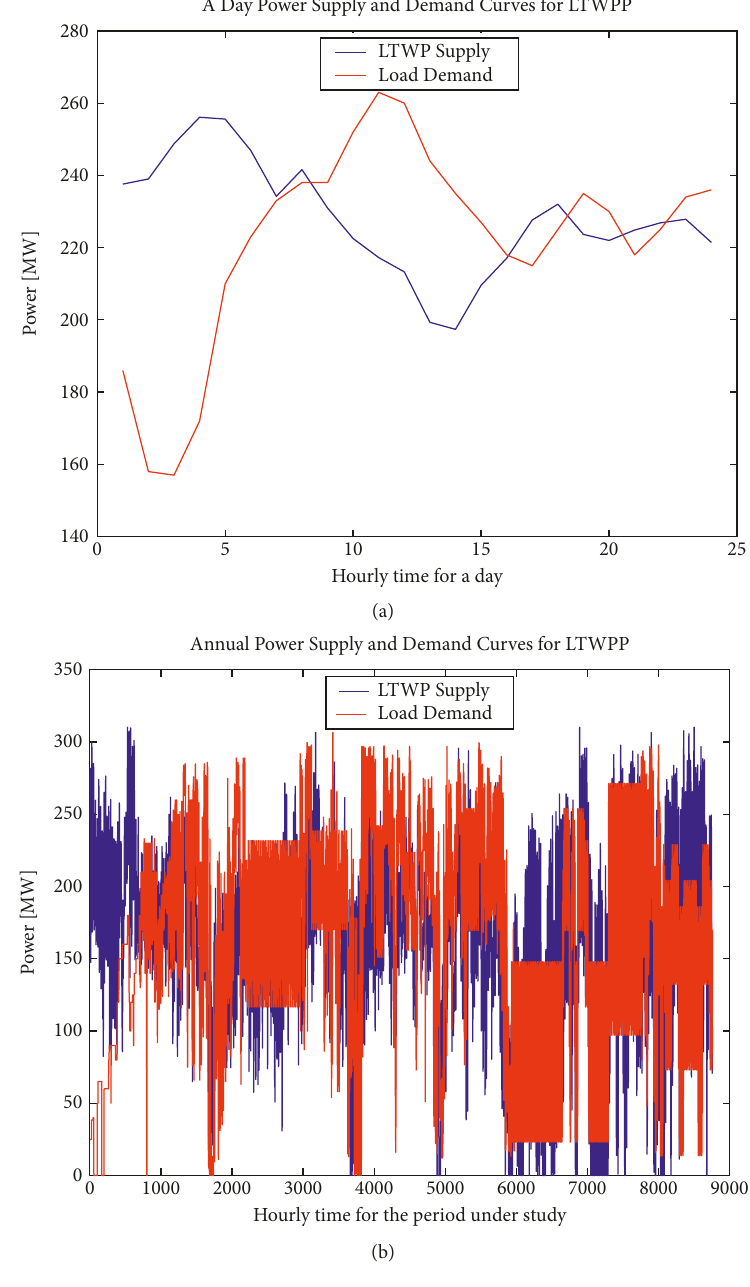
Figure 14: A 1-day (a) and an annual (b) supply and demand curves for LTWPP.